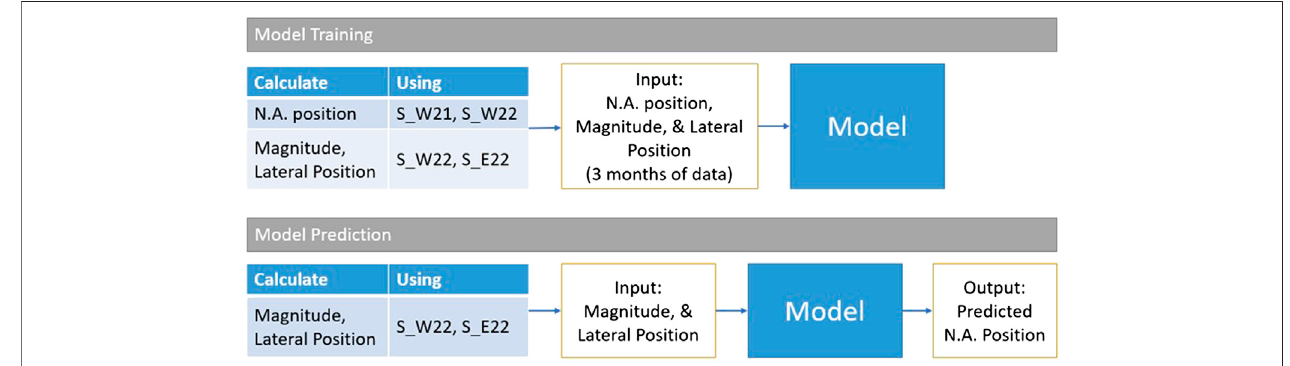
FIGURE 8 | Data mining model trained to predict N.A. position based on the estimations of the Magnitude and the Lateral Position of the traf fi c load.